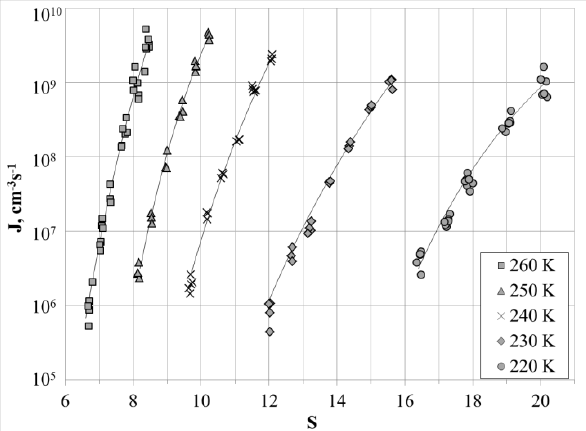
Fig. 5. Experimental data of water homogenous nucleation with nitrogen as carrier gas.